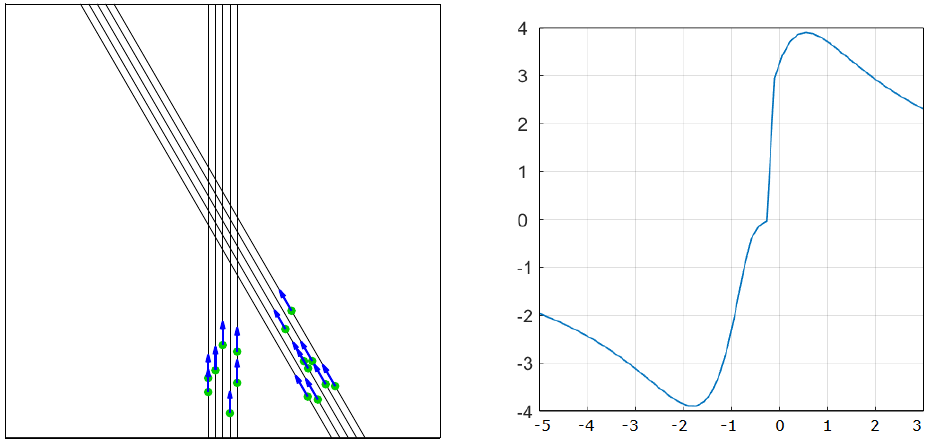
Figure 15. S-N and E-W flows, crossing at 30°. Traffic situation on the left and complexity function of time on the